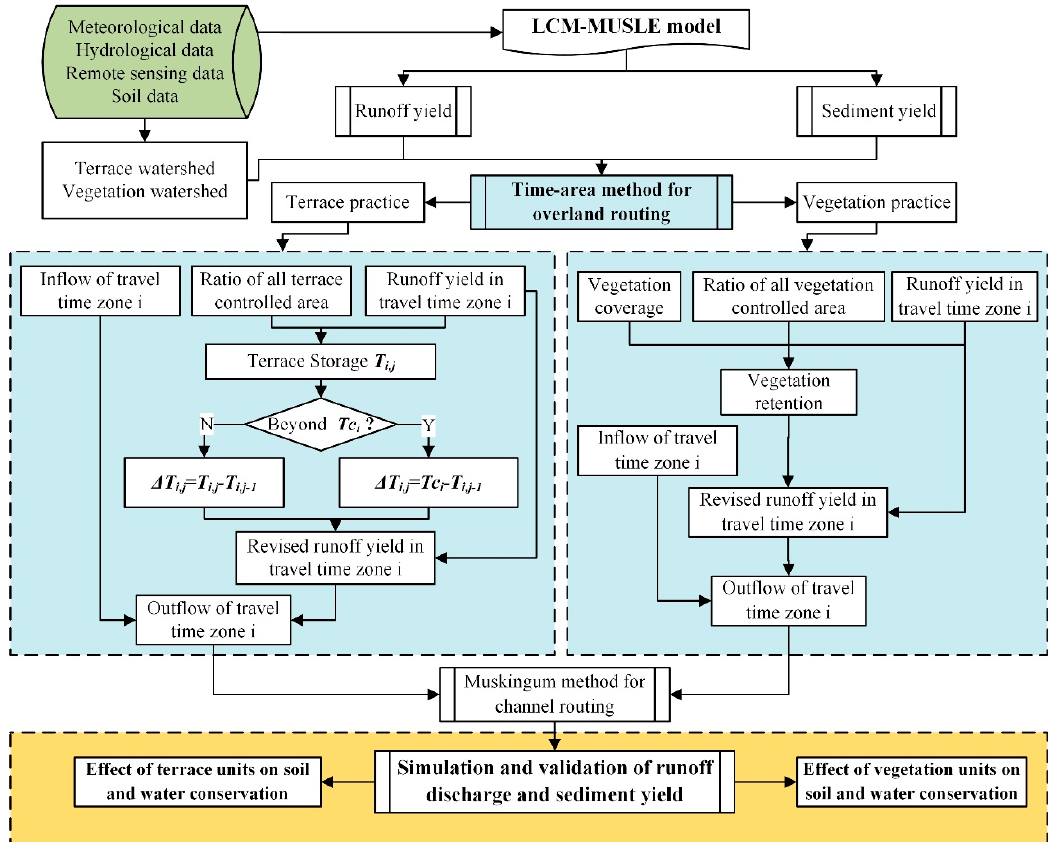
Figure 2. Framework of revised integrated model. T i,j is the amount of stored water or sediment in all terraces in travel time zone i at present time step j (m 3 or t); T i,j-1 is the amount of stored water or sediment in all terraces in i at previous time j -1 (m 3 or t); and Tc i is water storage capacity of all